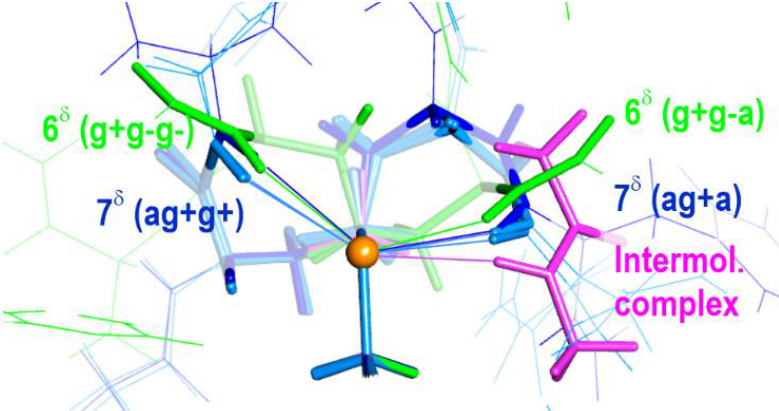
Figure 6. Comparison of the NH···Se approaches of the relevant conformations (5-7 δ g+/g — 7 L light blue, 5-7 δ /5 a - π dark blue and 6 δ - π g+ -10 green) of the Ac-Sem-Phe-NH 2 compound, as found at the DFT-D level of theory. The terminal part of all the Sem side-chains was overlaid (Se atom in dark yellow), allowing to distinguish the effect of the χ 3 dihedral orientation (side-chain dihedrals between parentheses). For the sake of clarity, front atoms were omitted and background atoms shaded. For reference, the structure of the MAA···S-SeMe 2 intermolecular complex was also added. The same figure for the Ac-Met-Phe-NH 2 compound, provided as Figure S1 in the Supplementary Material, illustrates the similarities between the two species.